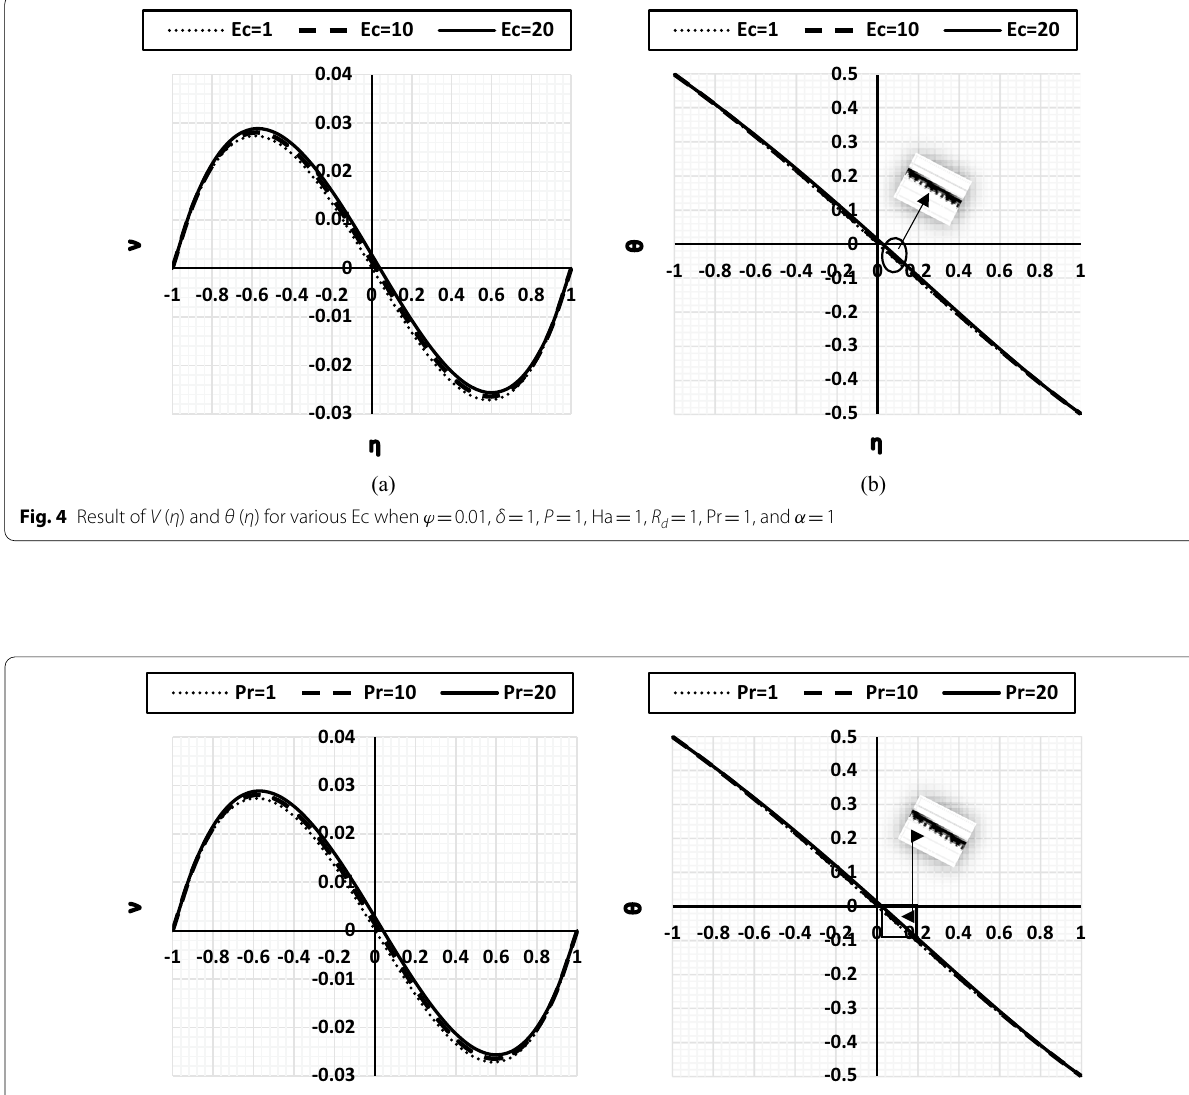
0.01, δ 1, P 1, Ha 1, Ec 1, R d 1, and α = = = = = =